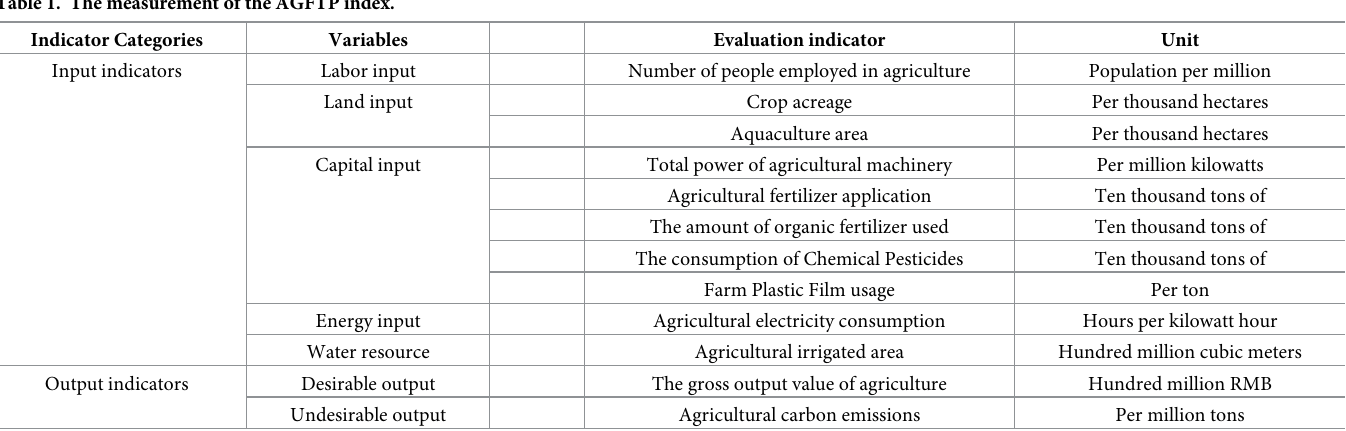
Table 1. The measurement of the AGFTP